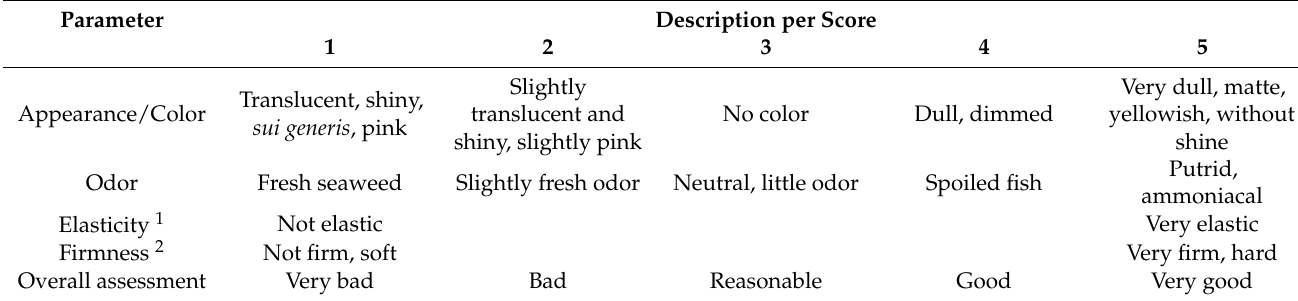
Table 1. Sensory parameters assessed in triggerfish fillets packed in air (AIR), vacuum (VP), and modified atmosphere